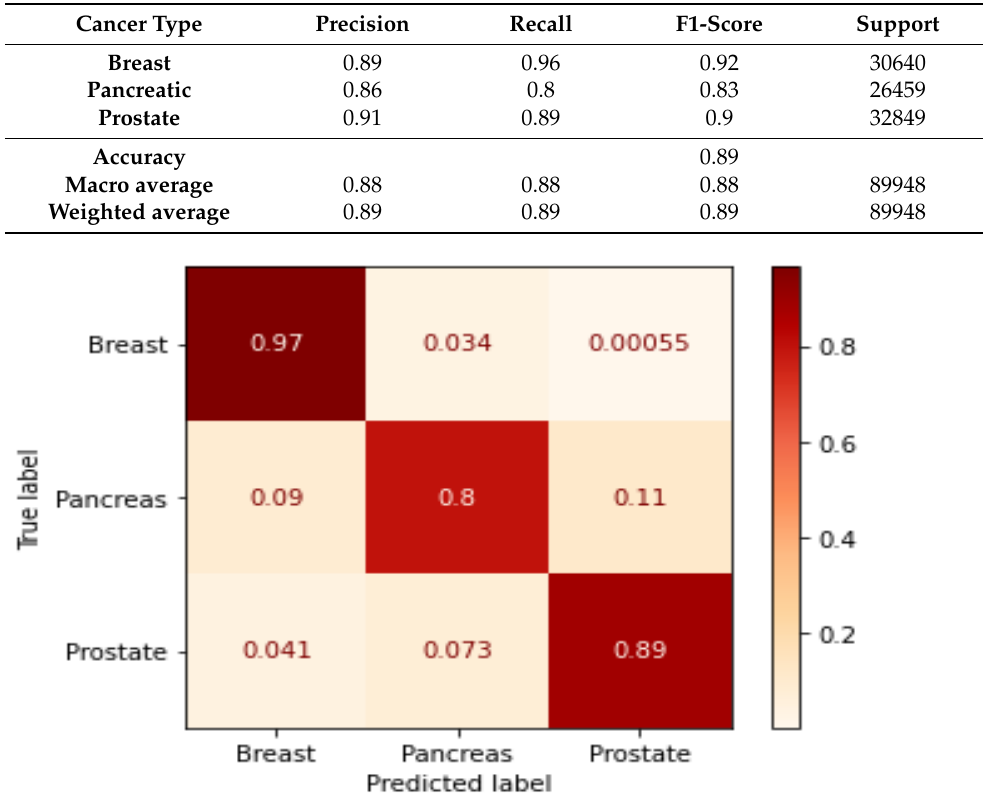
Table 2. Evaluation metrics (%).